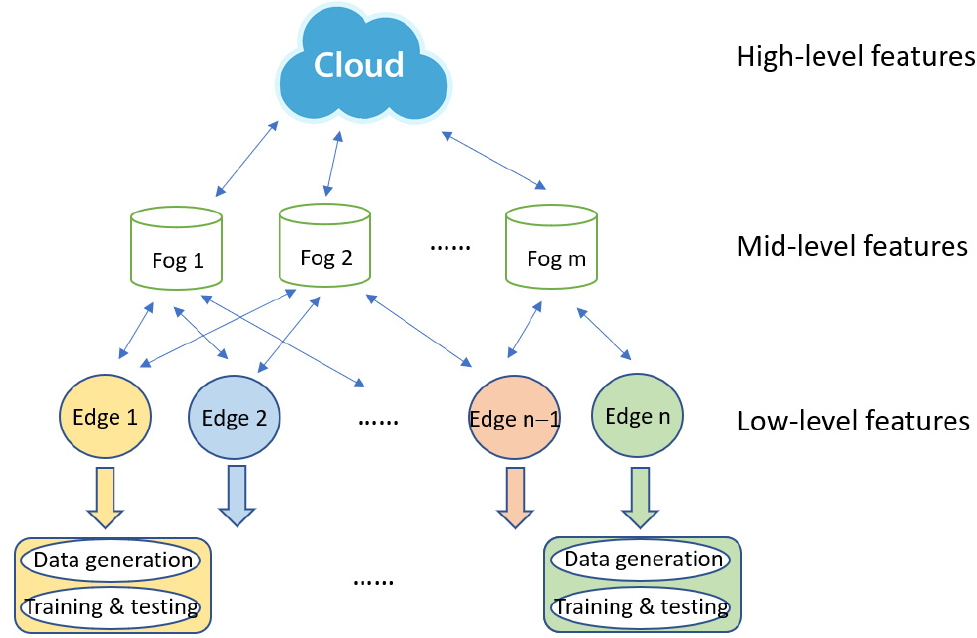
Figure 4. The architecture of the proposed system.